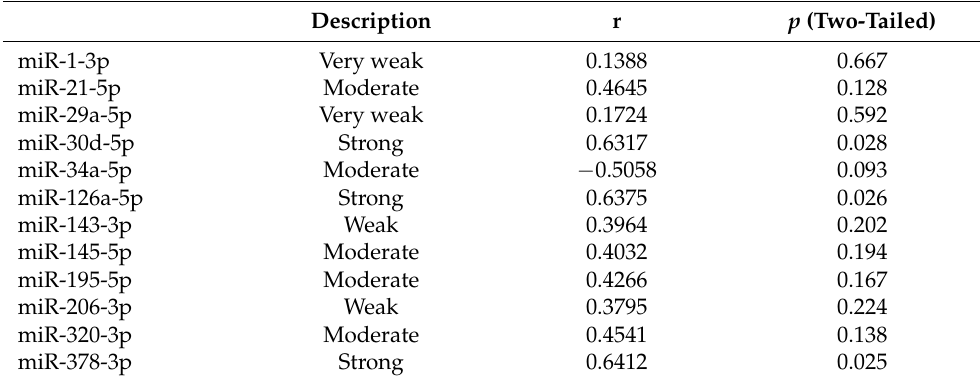
Table 2. Pearson correlation between EXO-miRNAs and cardiac output.